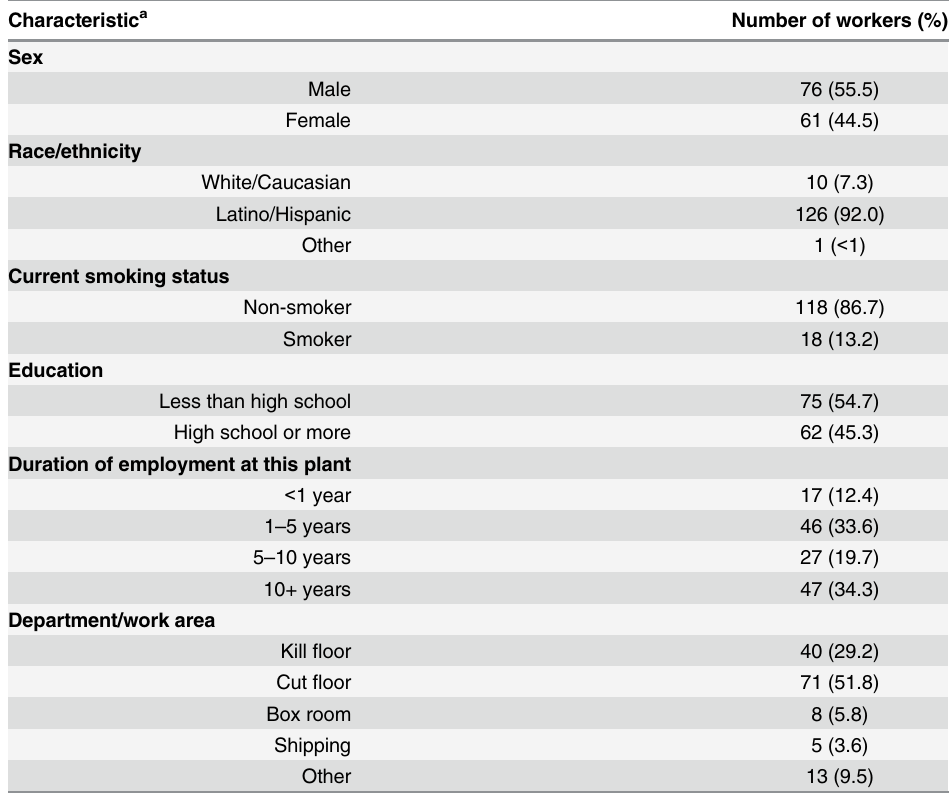
Table 1. Demographic and employment characteristics of beef meatpacking workers, Nebraska, United States (n =